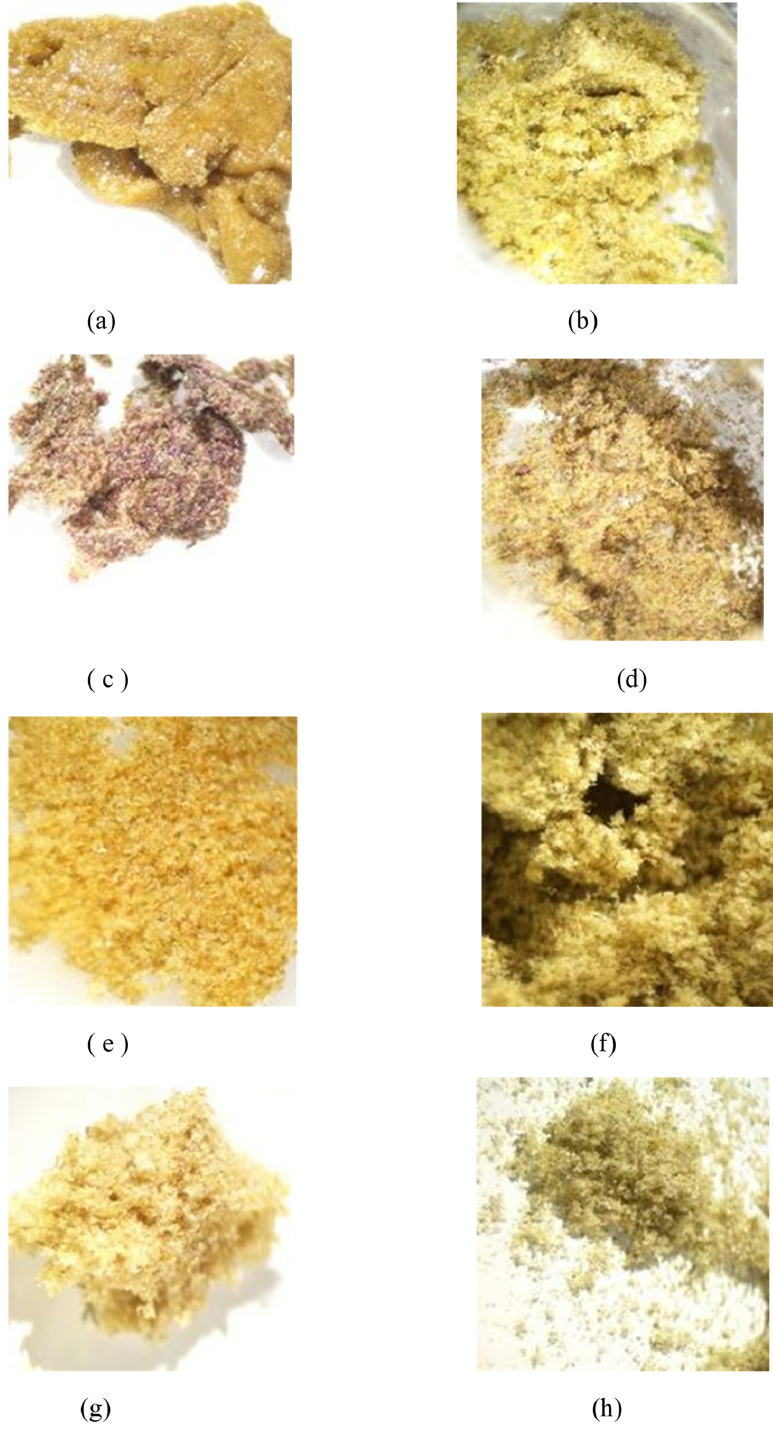
Figure 3. ( a ) Sample of Kryo-Kief™ from Doug Fir Type I chemovar; ( b ) sample of dried kief from Doug Fir Type I chemovar; ( c ) sample of Kryo-Kief™ from Astral Works Type II chemovar; ( d ) sample of dried kief from Astral Works Type II chemovar; ( e ) sample of Kryo-Kief™ from Tangie Biscotti Type I chemovar; ( f ) sample of dried kief from Tangie Biscotti Type I chemovar; ( g ) sample of Kryo-Kief™ from Ursa Major Type I chemovar; ( h ) sample of dried kief from Ursa Major Type I chemovar (images provided with permission of Lightscale Labs, Portland, OR,